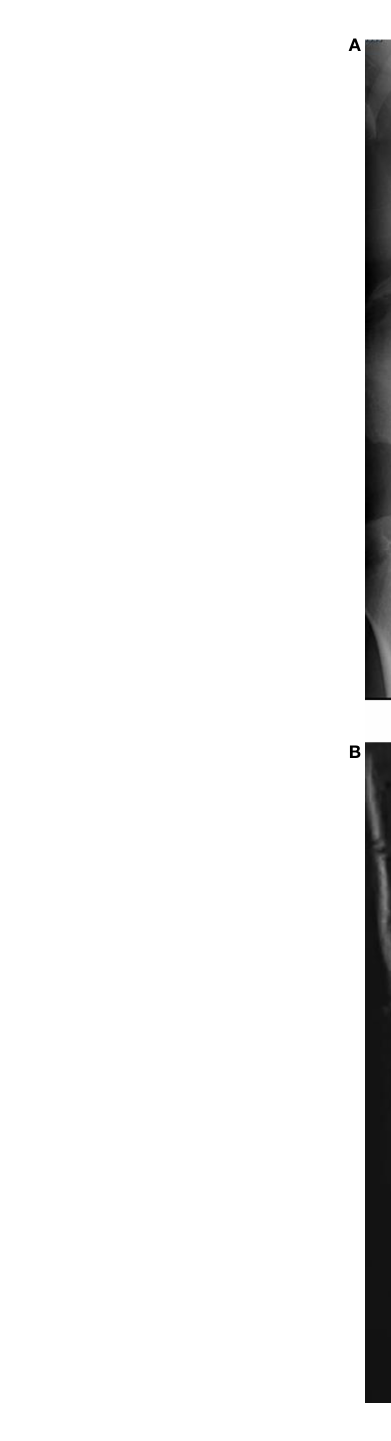
FIGURE 3 | (A) , X-ray iodized water radiography of digestive tract showed no delayed anastomotic leakage in the trans-anastomotic drainage tube (TADT) group (six months after operation). (B) , MRI showed no obviously delayed anastomotic leakage in the trans-anastomotic drainage tube (TADT) group six months after